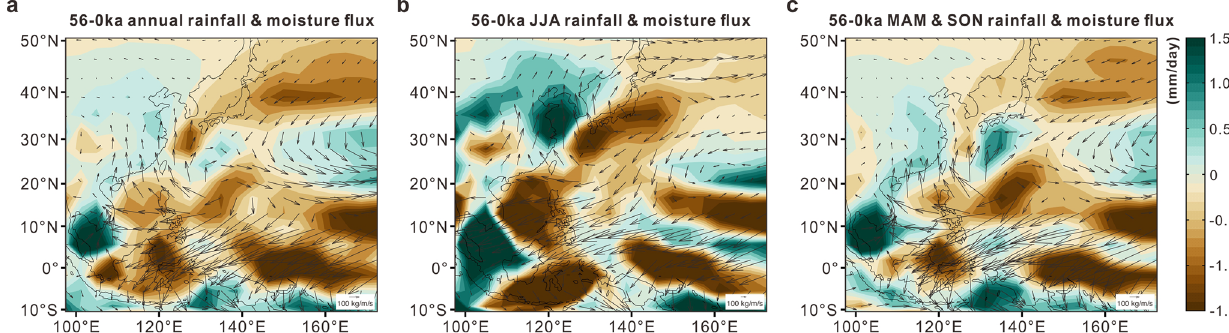
Fig. 4 Full forcing simulation of rainfall and moisture fl ux (arrows, kg/m/s) differences between 56 ka and present. a annual, b JJA, c MAM and